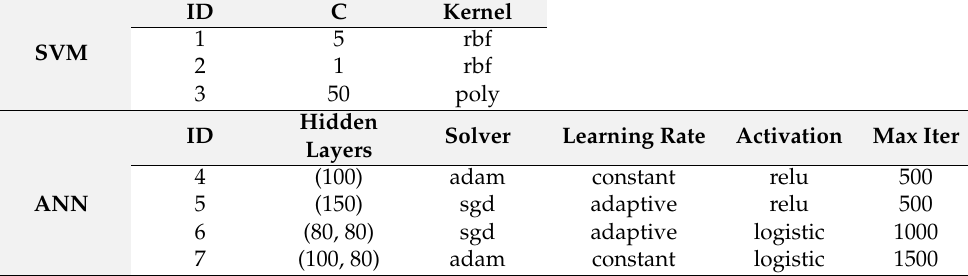
Table 2. ML classifiers (implementation details). Parameters’ names are reported according to the scikit-learn documentation